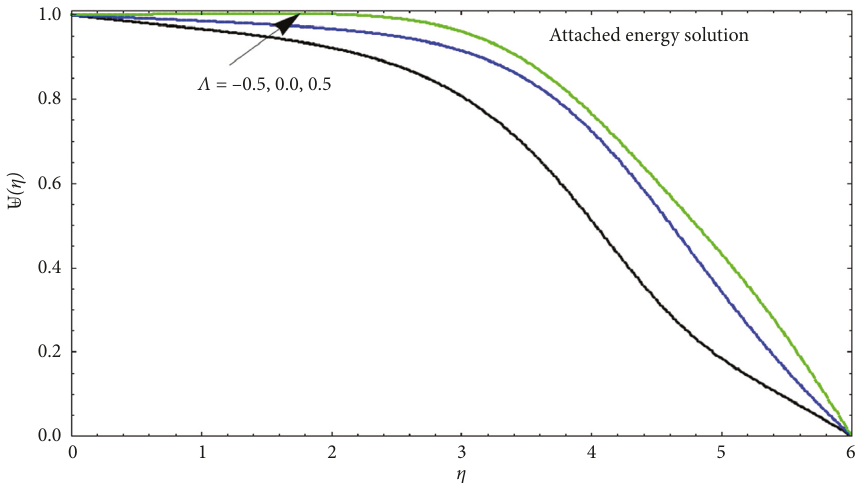
Figure 8: Dissimilarity of ⊎ ( η ) being some different values of Λ and Pr � 1 for only AFS.